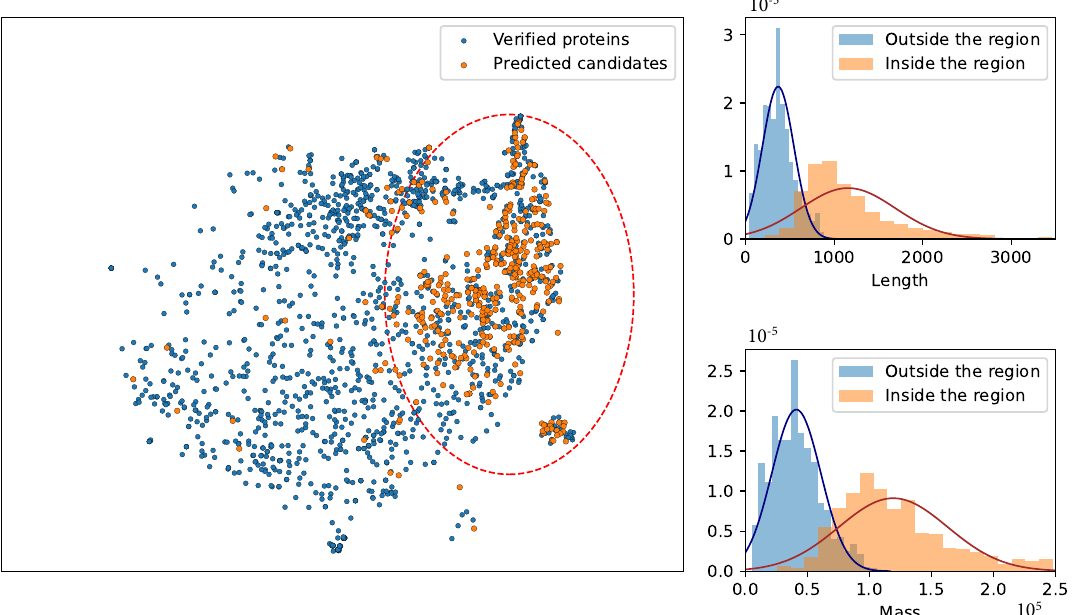
Figure 3. The flowchart of glioma biomarker identification.